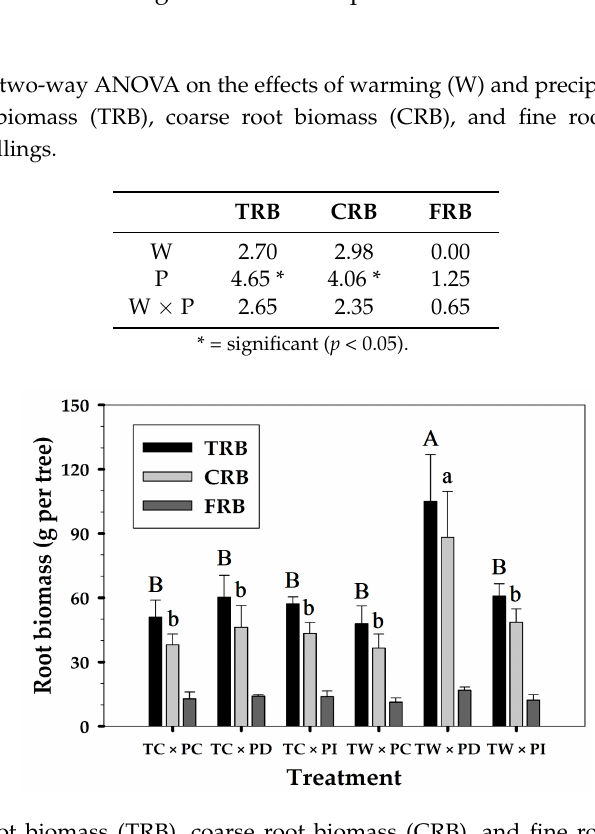
Figure 2. Total root biomass (TRB), coarse root biomass (CRB), and fine root biomass (FRB) of Pinus densiflora seedlings for each treatment in March 2016. Vertical bar indicates one standard error ( n = 3). Values followed by a different letter are significantly different ( p < 0.05). The treatment abbreviations are the same as in Table 2. Table 4. Results of multiple regression analysis of fine root biomass of Pinus densiflora seedlings as a function of soil temperature (ST) and soil moisture (SM).